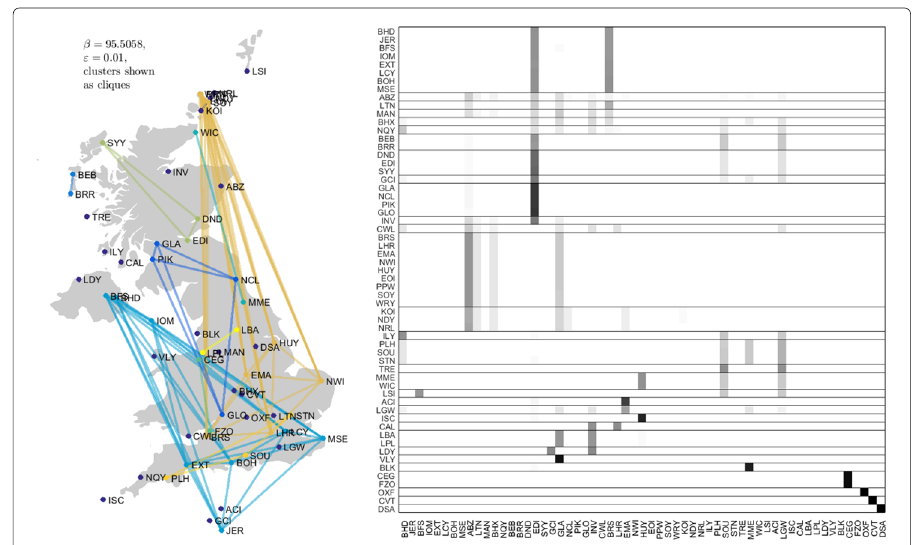
Fig. 7 Clusters from UK flight data for Wednesday, 20 October 2010; otherwise as in Figure 5. Cluster colors only distinguish clusters from each other and do not suggest affinity across days